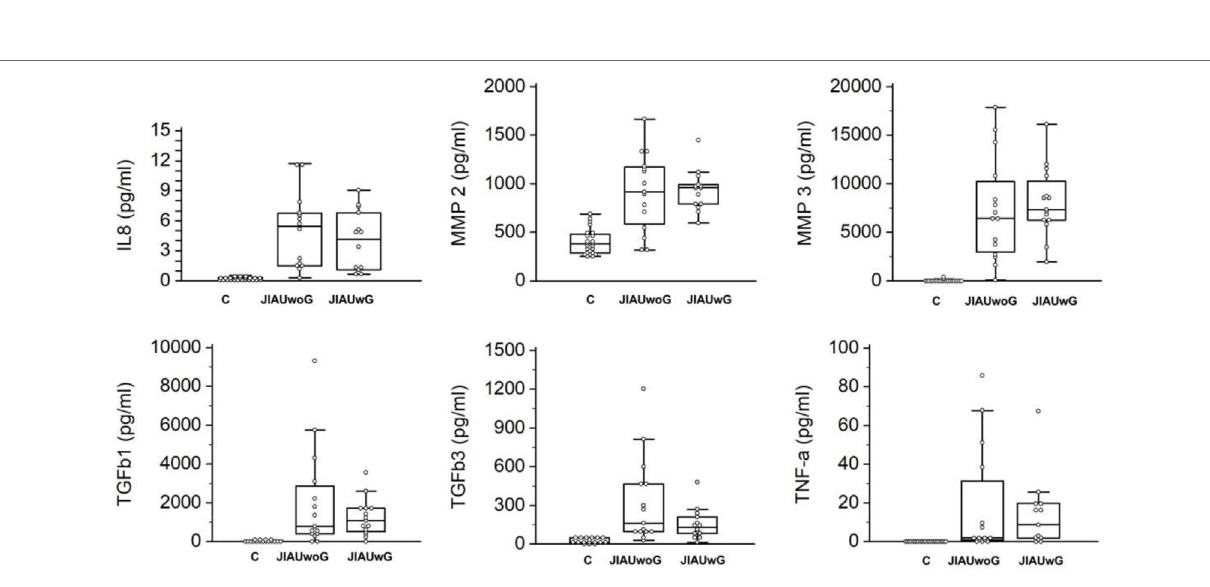
FigUre 2 | Box plots of interleukin-8 (IL-8), matrix metalloproteinases (MMP)-2, MMP-3, transforming growth factor beta (TGF β )-1, TGF β -3, and tumor necrosis factor-alpha (TNF- α ) in patients with juvenile idiopathic arthritis-associated uveitis with or without glaucoma. Specimens collected from patients with senile cataract served as a control. Dots represent individual values. ANOVA with Bonferroni correction (IL-8: P = 0.004, MMP-2: P < 0.001, MMP-3: P < 0.001, TGF β -1: P = 0.003, TGF β -3: P = 0.002, TNF- α : P = 0.005). Comparison between two groups by t -test.